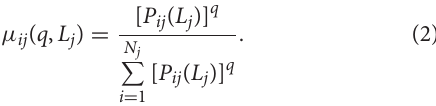
CJ method estimates P ( L ) for N L nonoverlapping L -sized bins